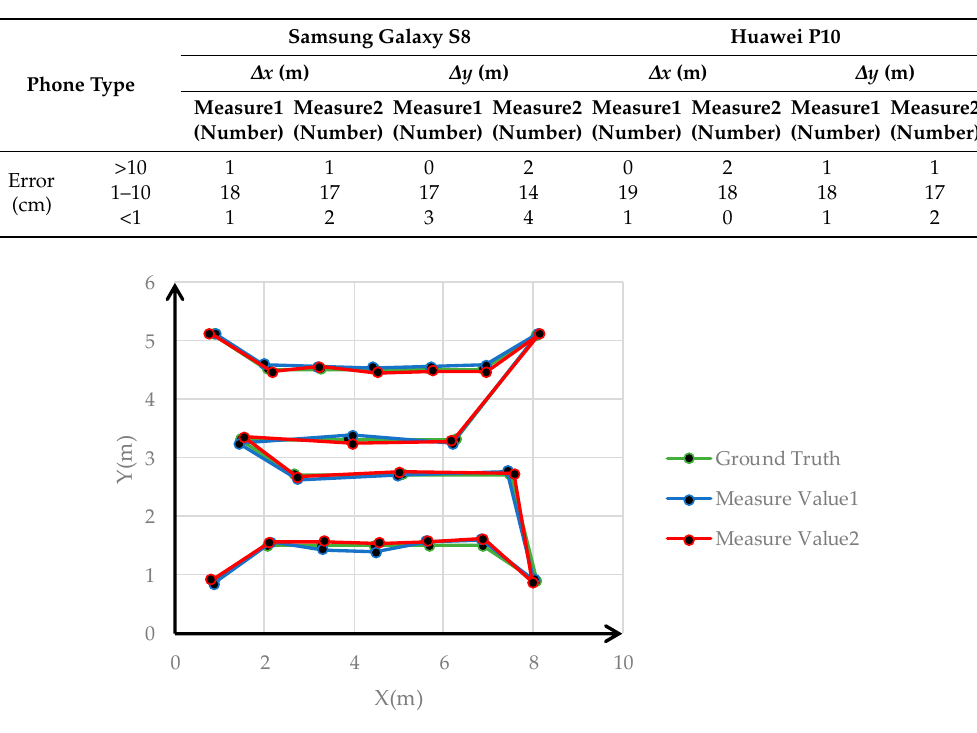
Table 3. The number of different accuracy positioning points of the Samsung Galaxy S8 smartphone and Huawei P10 smartphone.